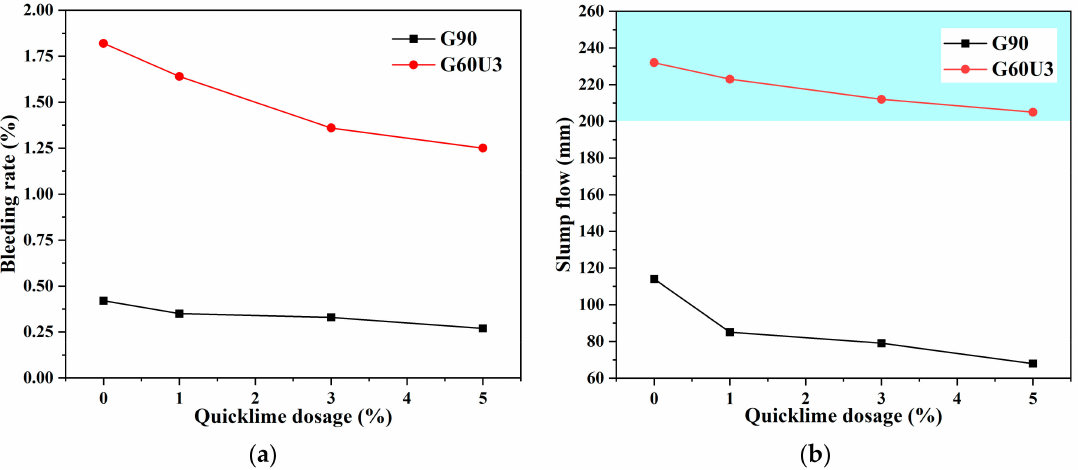
Figure 8. The ( a ) Bleeding rate ( B w ) and ( b ) slump flow ( D f ) of GBM slurry using G90 and G60U3 with the addition of